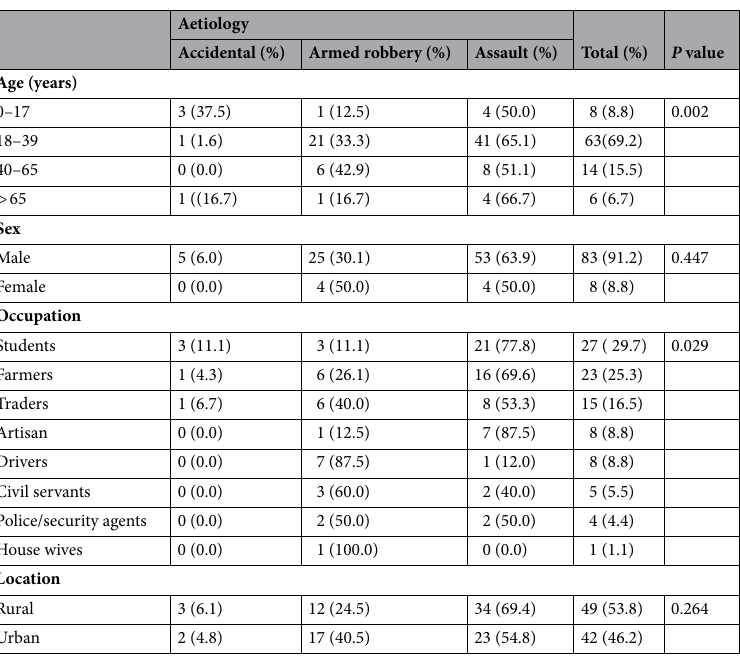
Table 1. Aetiology of machete cut fractures by demographic characteristics and location.